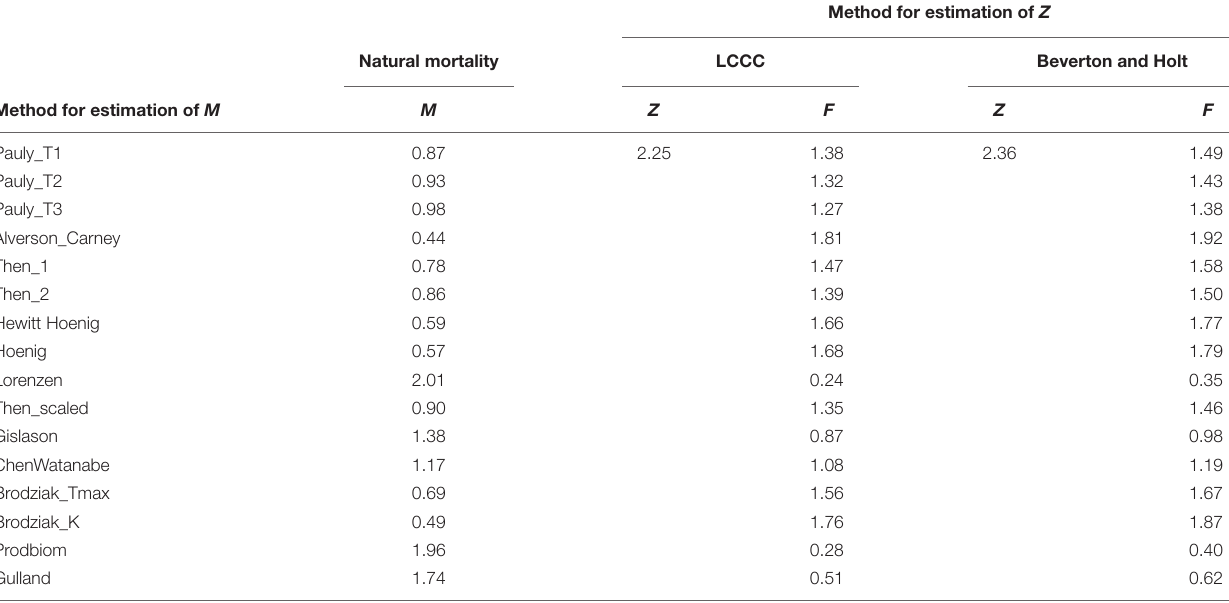
TABLE 4 | Values of fishing, natural and total mortality as given by the equation: total mortality rate (Z) = natural mortality rate (M) + fishing mortality rate (F). Method for estimation of Z Natural mortality LCCC Beverton and